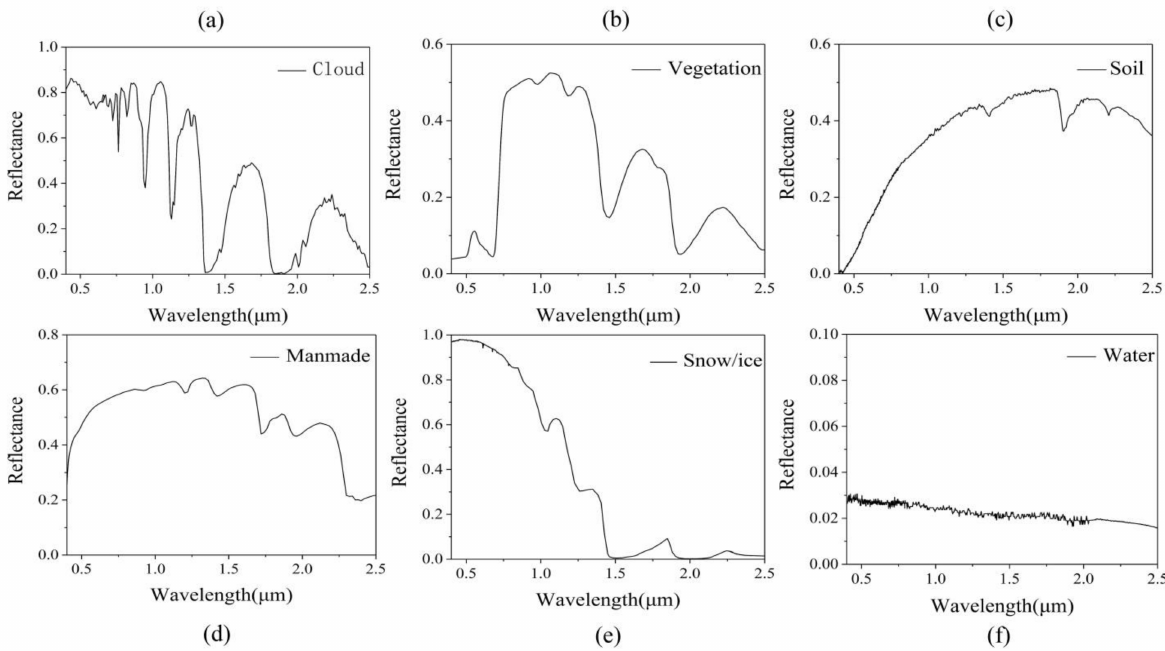
Figure 2. Spectra of different objects: ( a ) spectrum of cloud; ( b ) spectrum of vegetation [30]; ( c ) spectrum of soil [30]; ( d ) spectrum of manmade surface [30]; ( e ) spectrum of snow/ice [30]; ( f ) spectrum of water